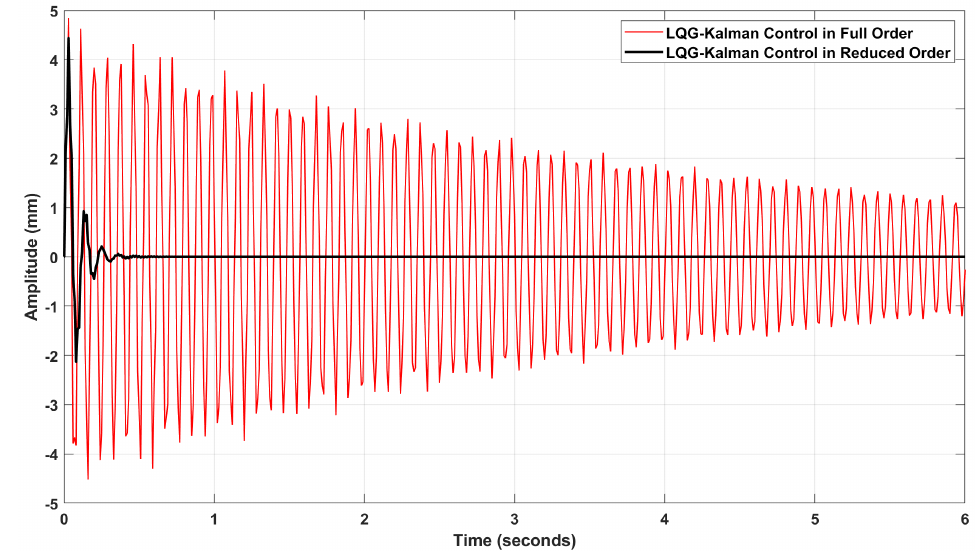
Figure 8. Impulse responses of control corresponding to the full and reduced LQG-Kalman models for T = 25 ◦ C with 8 distributed pairs of sensor/actuator and 20 selected sensors